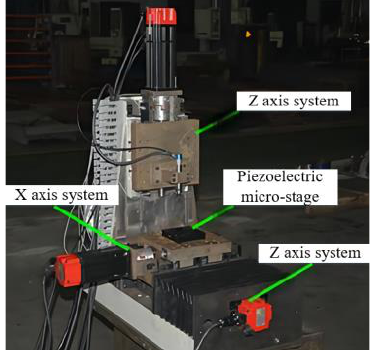
Figure 21. Micro-machine prototype diagram.